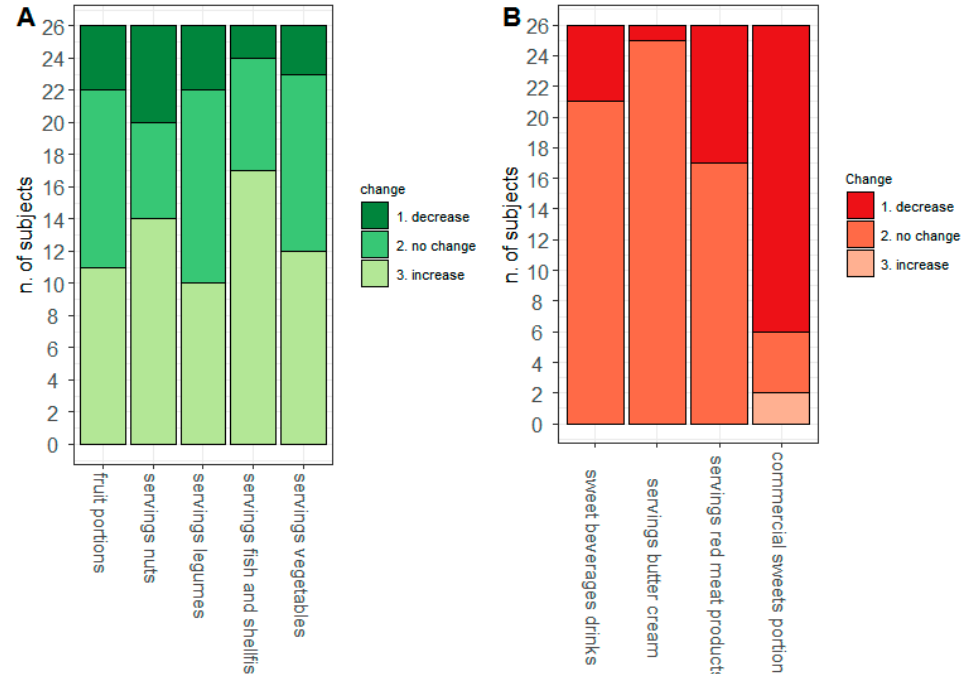
Figure 4. MEDAS modulation. On the x-axis are reported the dietary items considered and on the y-axis the number of subjects according to the absolute frequency of Recommended ( A ) and Not Recommended ( B ) intake.